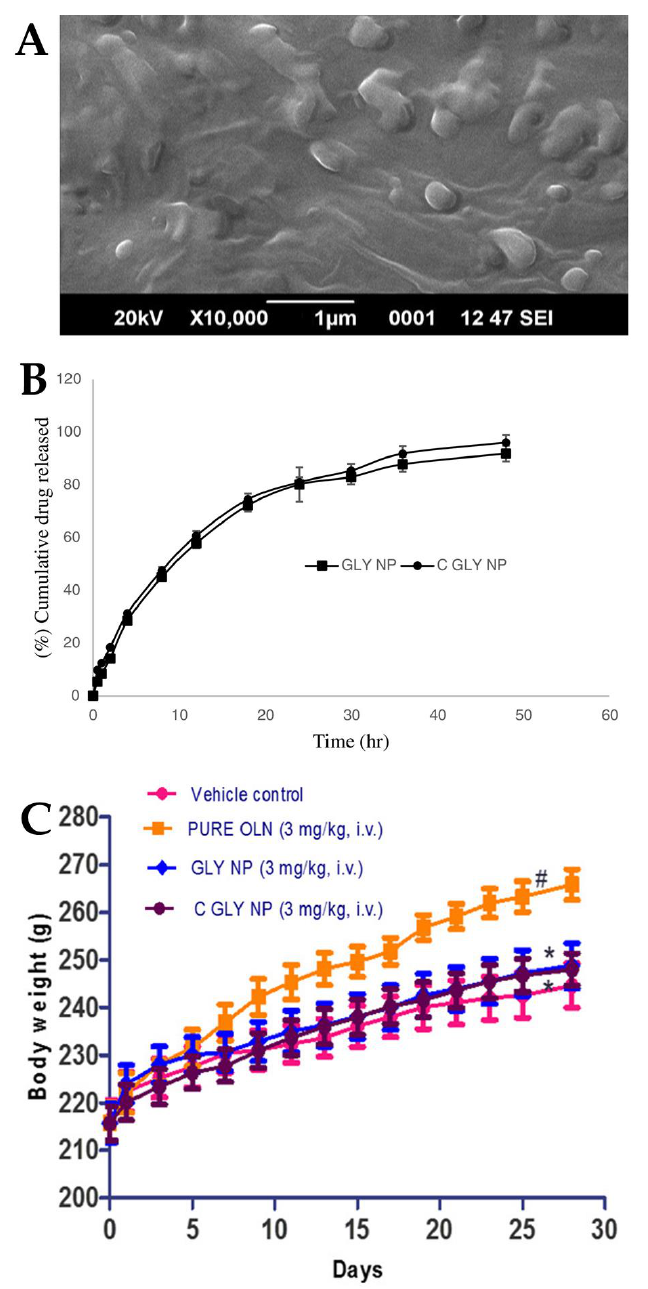
Figure 4. ( A ) Scanning electron microscope image of the developed olanzapine SLN; ( B ) In vitro drug release profiles of the optimized formulations, Tween ® 80 coated SLN (“GLY NP”) and non-coated SLN (“C GLY NP”); ( C ) Effect of IV formulation administration, namely olanzapine Tween ® 80 coated SLN (“C GLY NP”), olanzapine non-coated SLN (“GLY NP”), olanzapine solution (“PURE OLN”), and drugless vehicle (“Vehicle control”), on animal body weight; adapted from Joseph et al. [100], reproduced with permission from Elsevier [License Number 5477090054162].